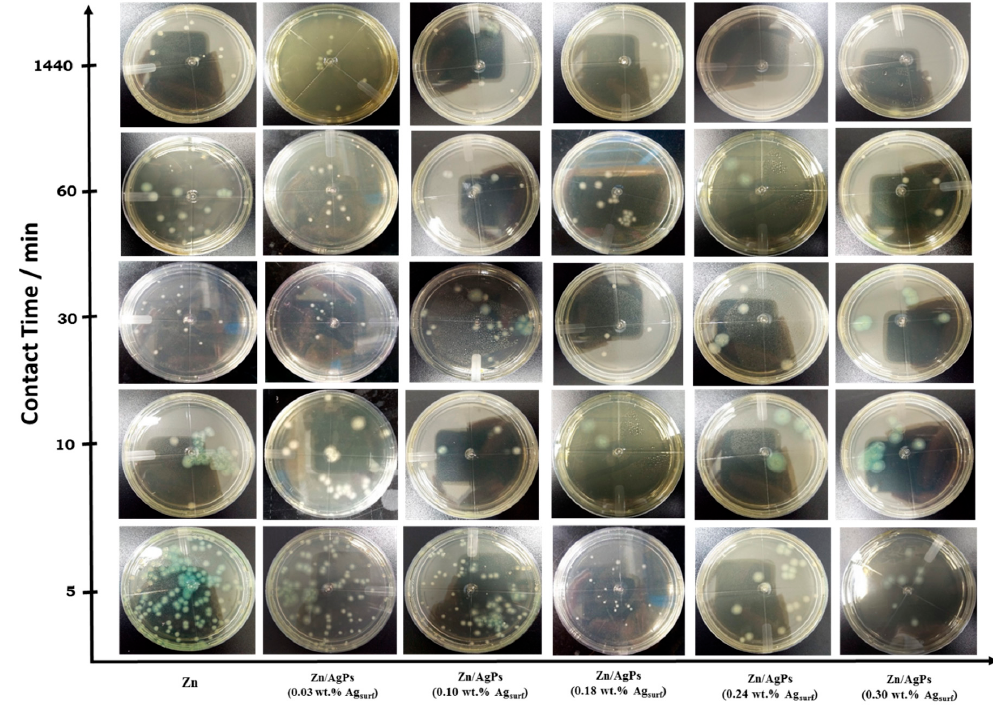
Figure 4. Agar plate assays to assess the antibacterial activity of Zn/AgP composite coatings with different contents (wt.%) of Ag and different contact times with the pathogenic Gram-negative bacterial strain P. aeruginosa and 24 h de incubation.